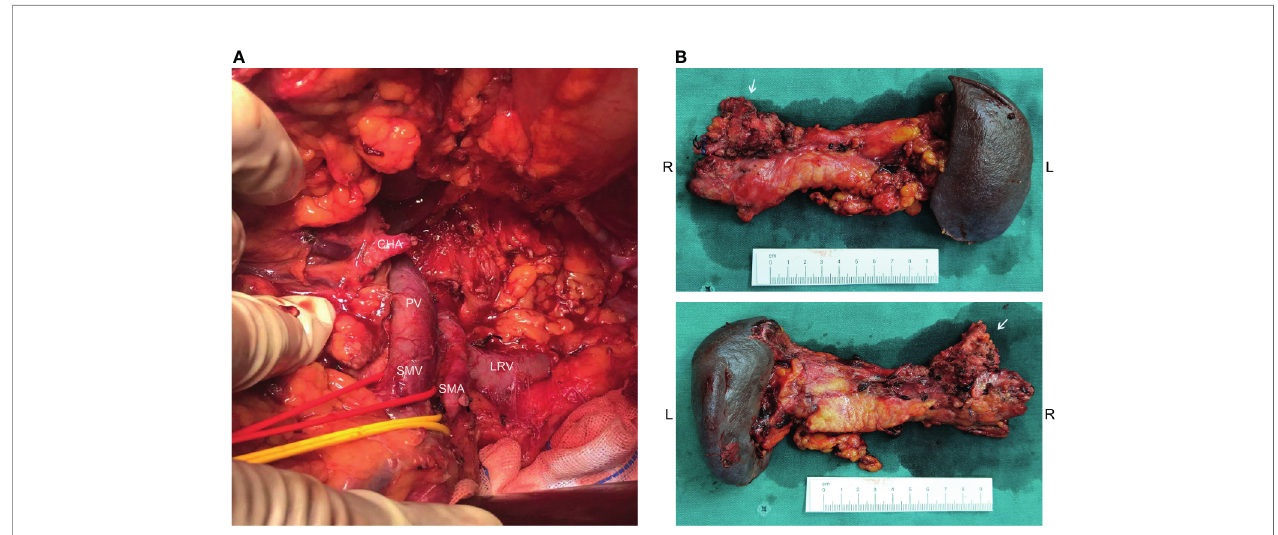
FIGURE 2 | Operative fi ndings and surgical specimen. (A) From the operative exploration, the tumor quality was tough, and about 3.0 cm x 2.0 cm x 4.0 cm in diameter, in fi ltrating the neck and body of the pancreas, invading the lesser curvature, left adrenal gland, and the left diaphragm. The tumor also invaded the celiac trunk, the common hepatic artery, the left gastric artery, the splenic artery, the splenic vein, and its branches. (B) An Appleby procedure was performed to completely remove the tumor, tumor invaded vessels, the distal pancreas, and the